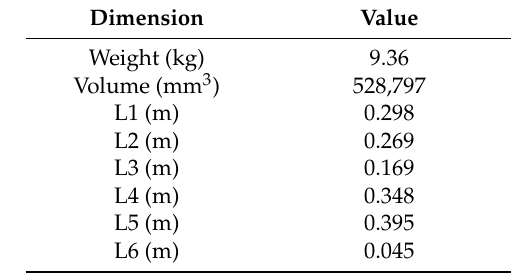
Table 1. Physical characteristics of the real